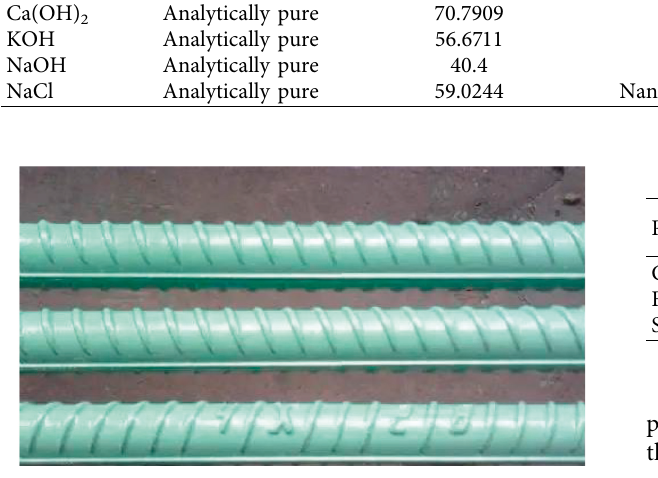
Figure 2: Coated reinforcement. Table 8: Spraying parameters.